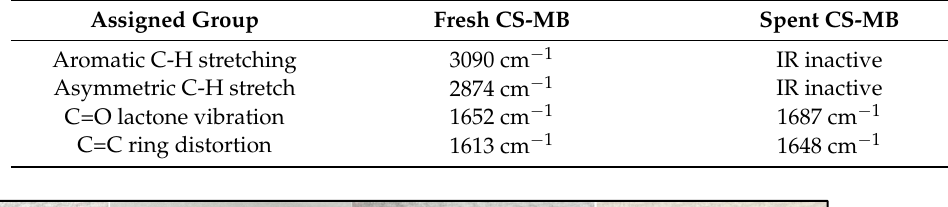
Table 4. Key FT-IR bands comparison between fresh and spent CS-MB. Assigned Group